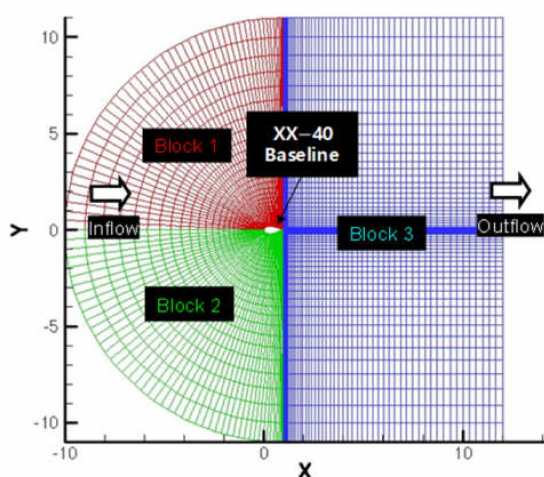
Figure 5. Overall view of computational grid